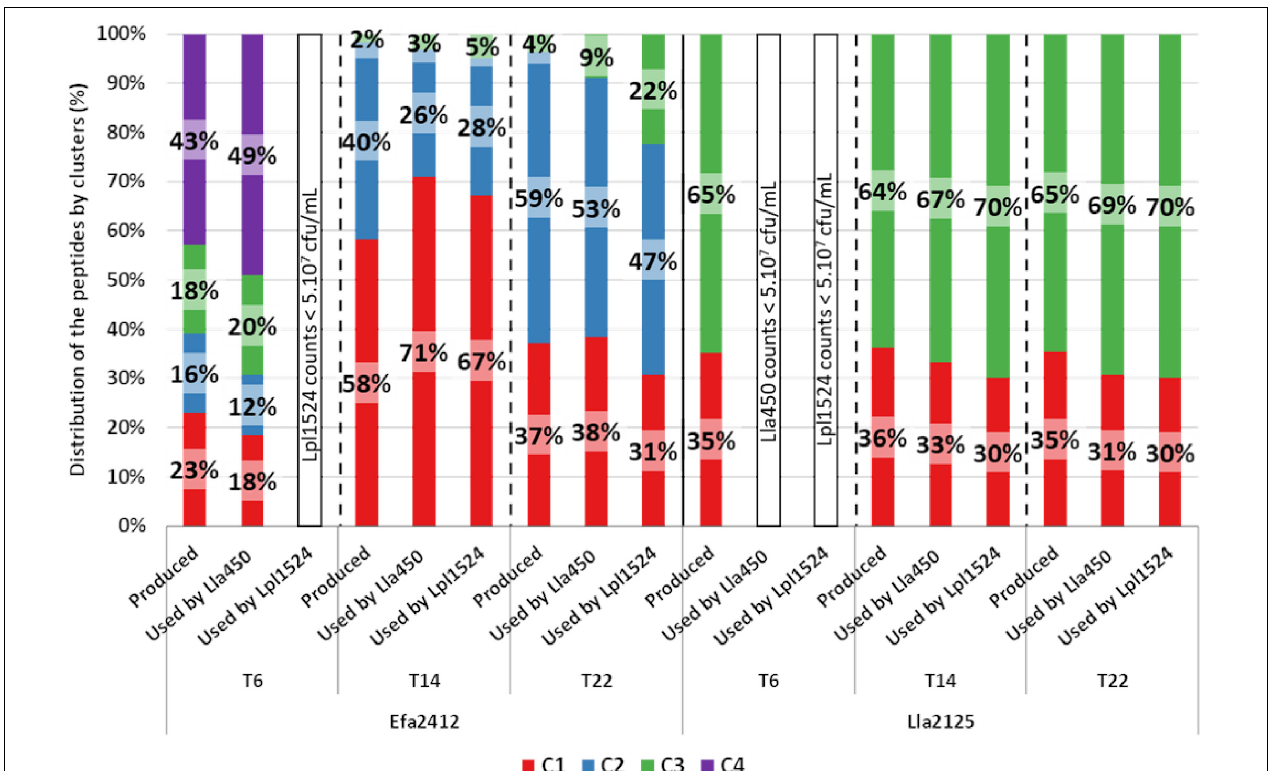
FIGURE 8 | Distribution of the peptides by clusters either (i) produced by the prot + strains Efa2412 and Lla2125 or (ii) used by the prot - strains Lla450 and Lpl1524 in co-culture with Efa2412 or Lla2125. Peptides considered as used by the prot - strains were the ones for which the abundance was significantly lower in co-culture than in monoculture of the prot + strain (Wilcoxon test, p -value <